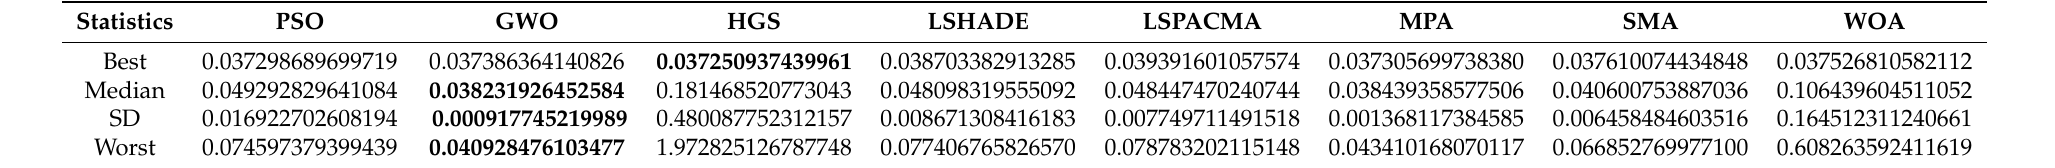
Table 3. Experimental result of MSE with 30 individuals, 20 evolutions and 30